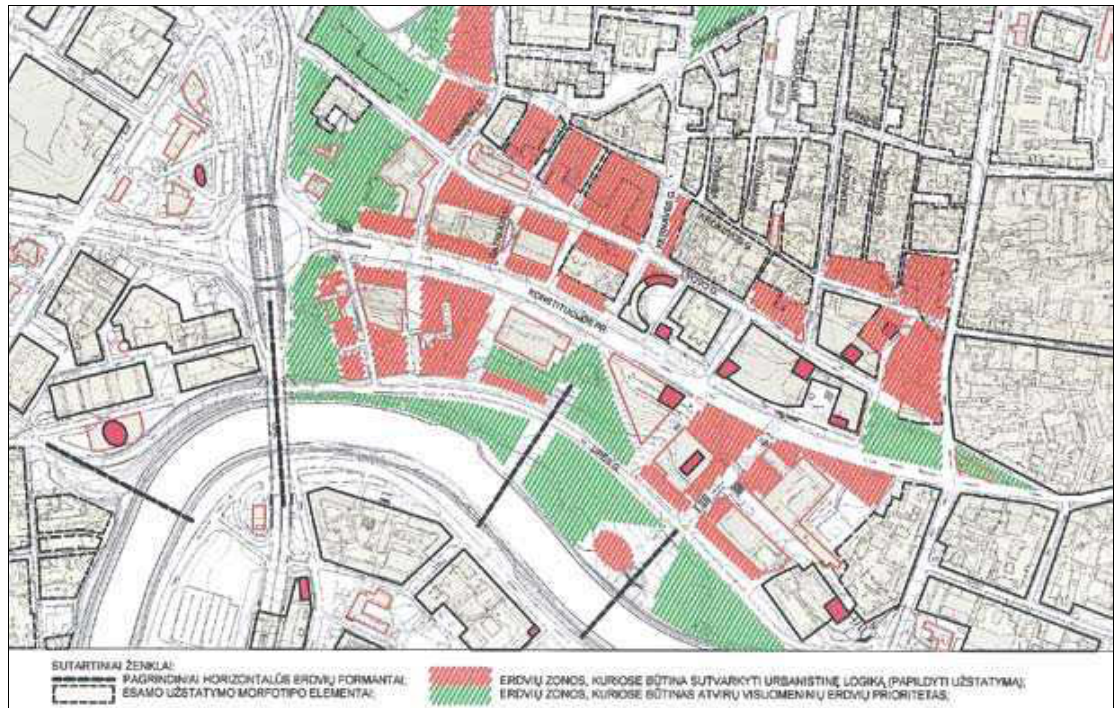
Fig. 4. Local areas and their reconstruction